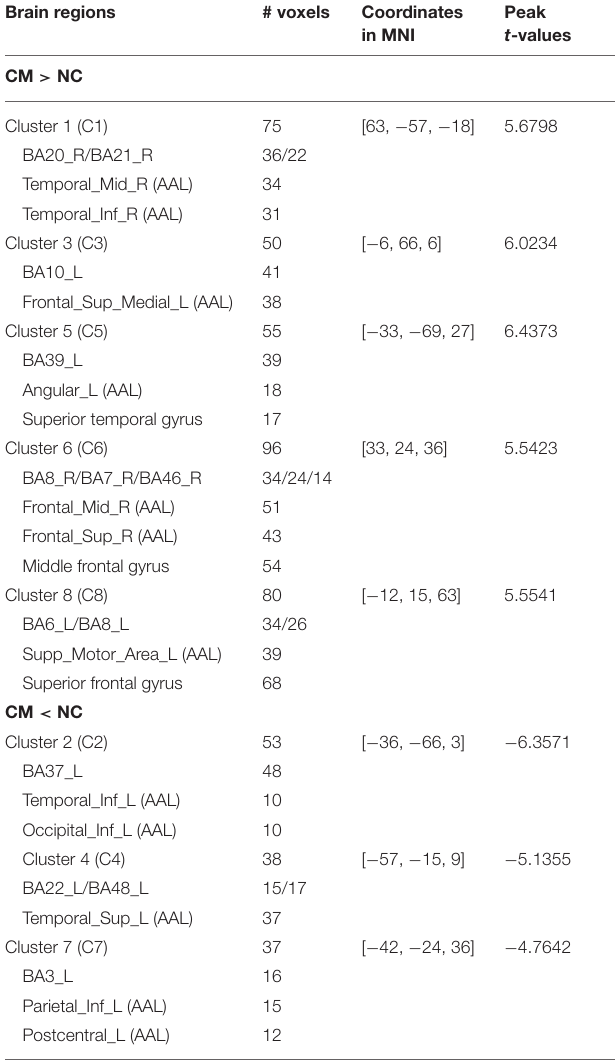
TABLE 1 | Brain regions with intergroup differences in amplitude of low-frequency fluctuation (ALFF) between congenital microphthalmia (CM) and normal controls (NC). Clusters 1–8 correspond to the 8 clusters in Figure 1